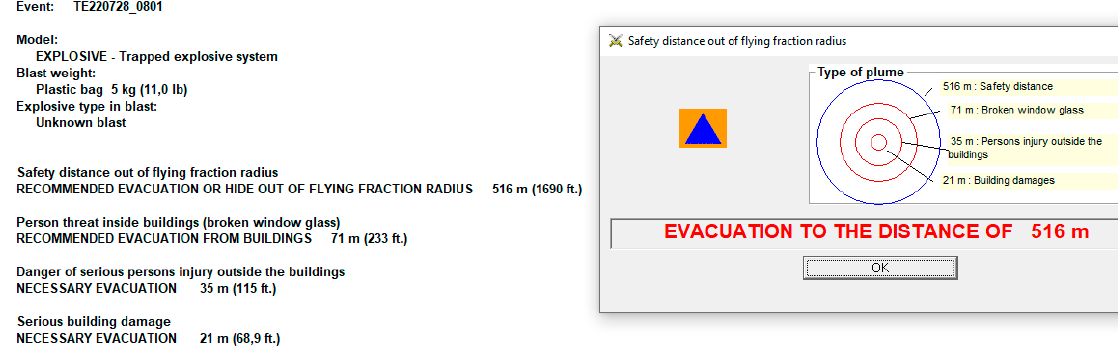
Figure 7. Initial information about the scope of the event.